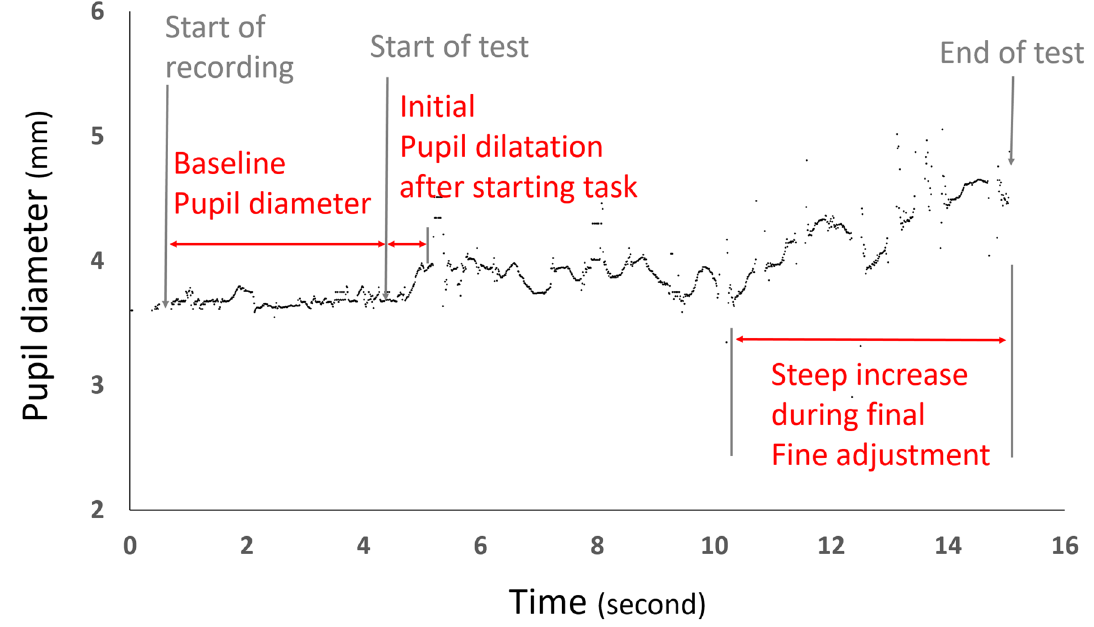
Figure 3. Examples of pupil response during measurement (from case #3, under clockwise rotational flow of 10°/s). Baseline pupil diameter was measured approximately 4 s prior to starting the test. Initial pupil dilatation was recorded after starting the test rod adjustment. Significant increase of the pupil diameter was observed when finely aligning the bar near the